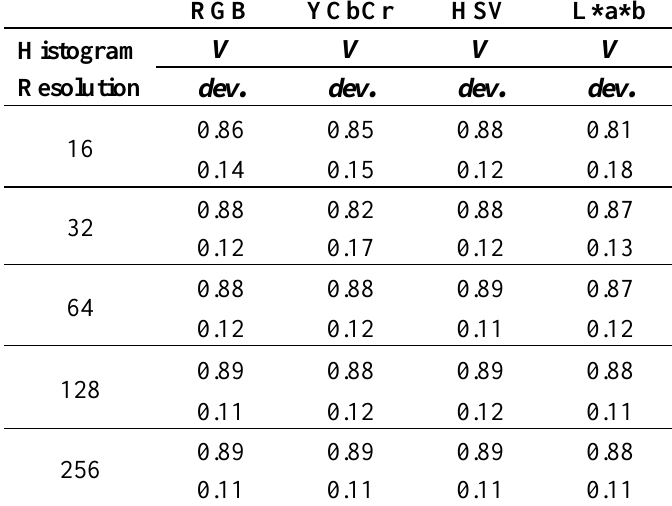
Table 1. The average and standard deviation of the sensitivity for each color space using 10-fold